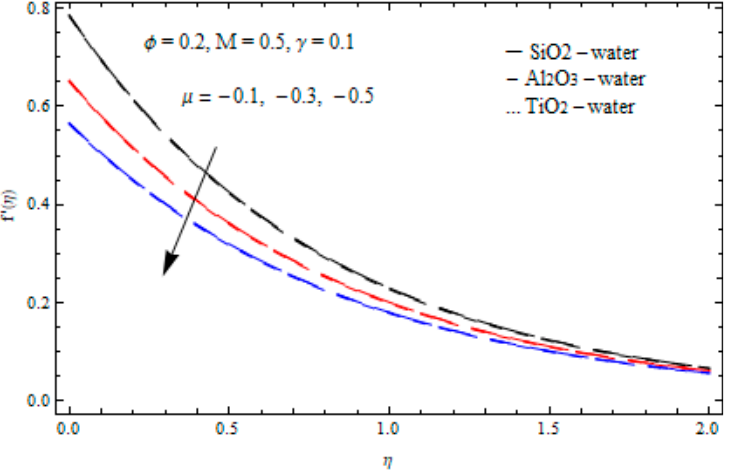
2 -water nanofluids. Mathematics 2018 , 6 , x FOR PEER REVIEW